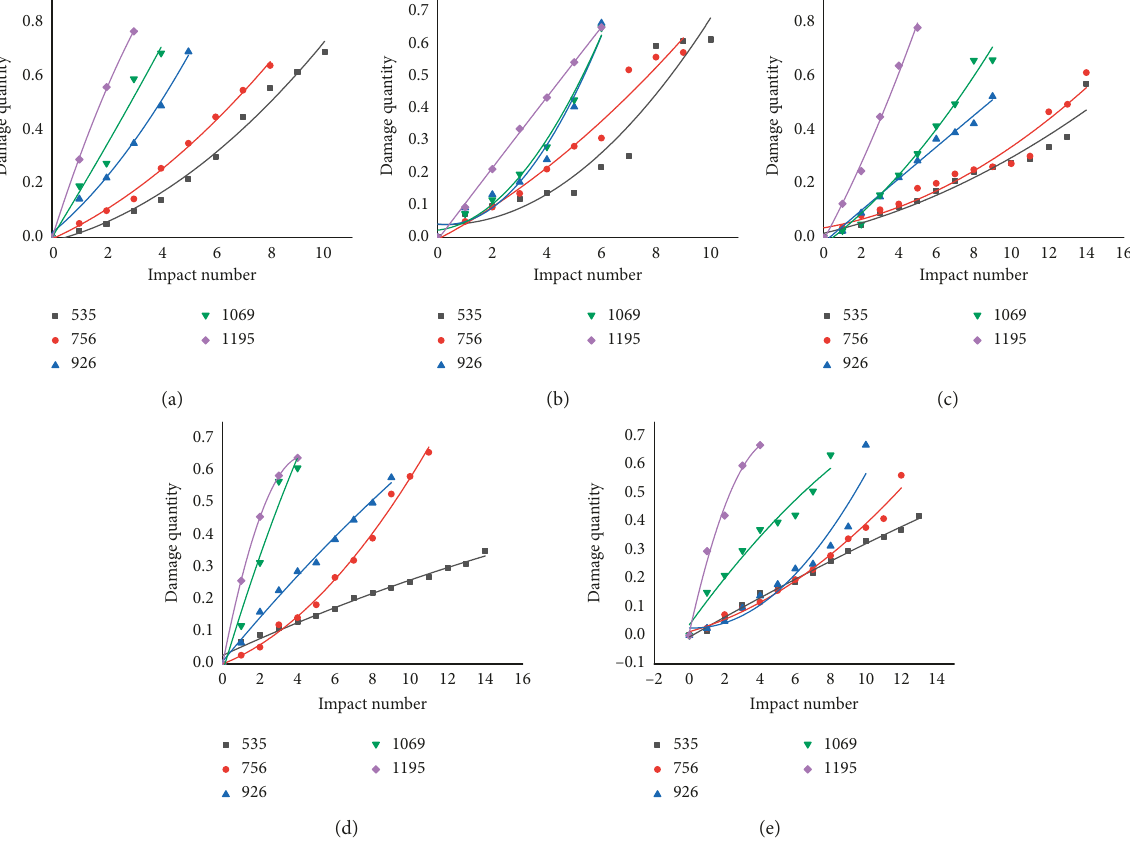
Figure 16: Relationship between damage quantity and impact number under different constraint static loads. (a) q (b) q 1.127MPa. (c) q 2.254MPa. (d) q 3.38MPa. (e) q (cid:31) (cid:31) (cid:31) (cid:31)